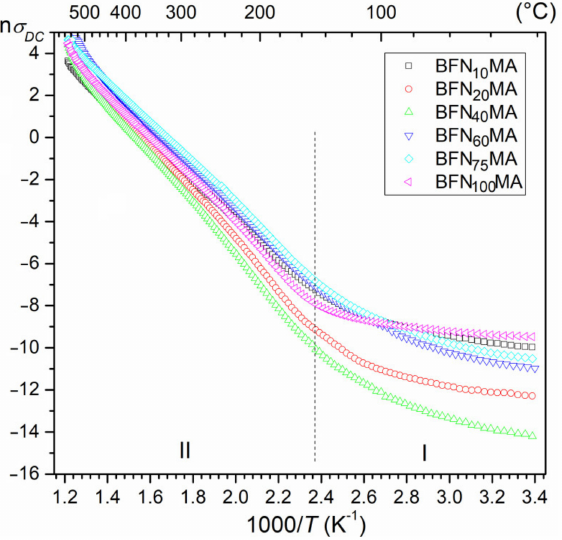
Figure 4. Temperature dependencies of electric conductivity for BFN x MA ceramic samples.